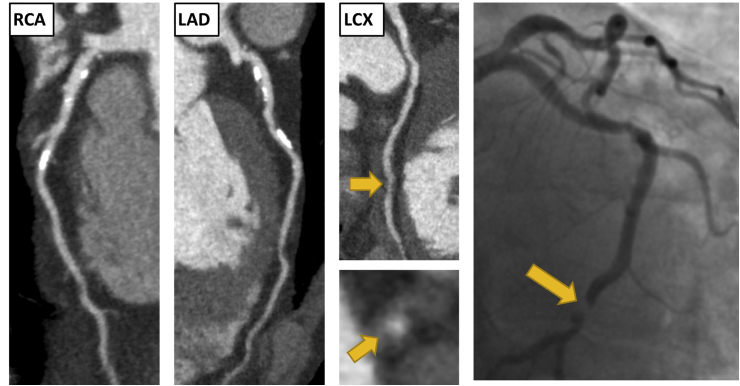
Clinical Vignette 1. A 65-year-old male presented to the rapid access chest pain clinic with symptoms of typical angina. He was a current smoker with a past medical history of gout. An exercise tolerance test was stopped early due to knee pain, but demonstrated no other abnormalities. His coronary artery calcium score was 283 Agatston units. He underwent a CCTA which showed moderate non-obstructive disease (CAD-RADS 3) He had mild calcified plaque in the left anterior descending (LAD) and right coronary artery (RCA), <50% stenosis. He had moderate non-calcified plaque with positive remodelling in the proximal and distal left circumflex artery (LCX), 50–70% stenosis. He presented 1 years later with an episode of acute chest pain on the background of 2 weeks of worsening chest pain. Electrocardiogram (ECG) on admission showed ST depression in the inferior leads. High sensitivity troponin I was elevated at 2060 ng/L. He was diagnosed with a non ST elevation myocardial infarction (NSTEMI). Invasive coronary angiography showed an occluded mid LCX (yellow arrows). There was also mild disease in the LAD and moderate disease in the small RCA. A bare metal stent was inserted into the LCX and he was asymptomatic on subsequent follow-up. . (For interpretation of the references to colour in this figure legend, the reader is referred to the Web version of this article.)